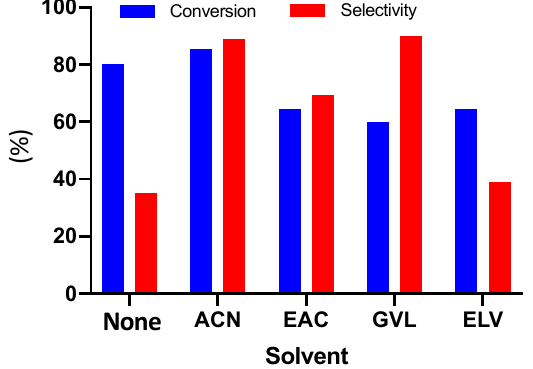
Figure 1. Conversion of double bonds (DB) and selectivity for epoxide, epoxidation, without solvent (RUN 1) and in the presence of different solvents (ACN: acetonitrile RUN 2; EAC: ethyl acetate, RUN 3; GVL: γ -valerolactone, RUN 4; ELV: ethyl levulinate, RUN 5. Experimental conditions: 600 mg of catalyst, 6.9 g of H 2 O 2 (60% wt.), 5 g (0.024 mol of double bonds) of cardoon oil, 20 cm 3 of solvent, and reaction temperature of 78–80 °C.